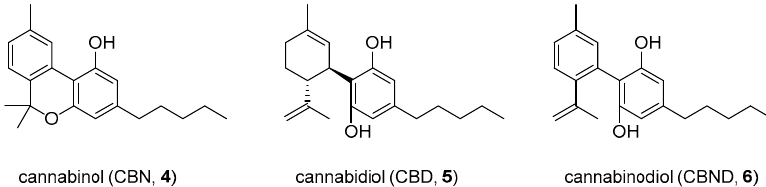
Figure 2. Chemical structures of the phytocannabinoids cannabinol (CBN), cannabidiol (CBD), and cannabinodiol (CBND).